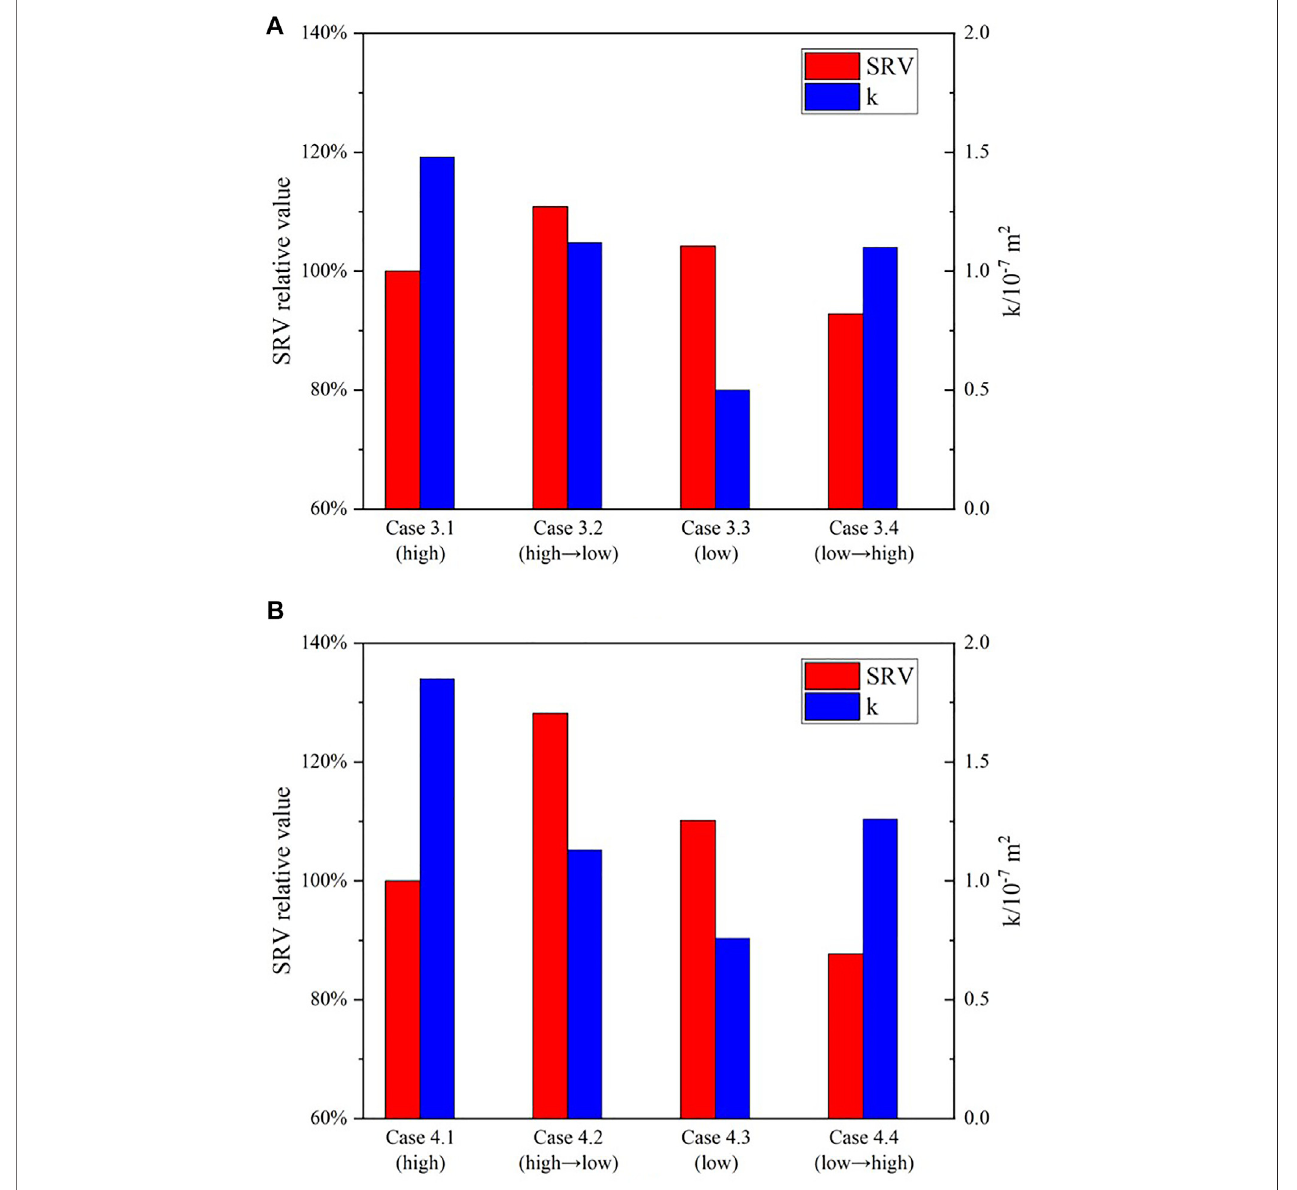
FIGURE 13 | The SRV and permeability of reservoir (A) NF dip angle is 45 ° ; (B) NF dip angle is 30 ° .